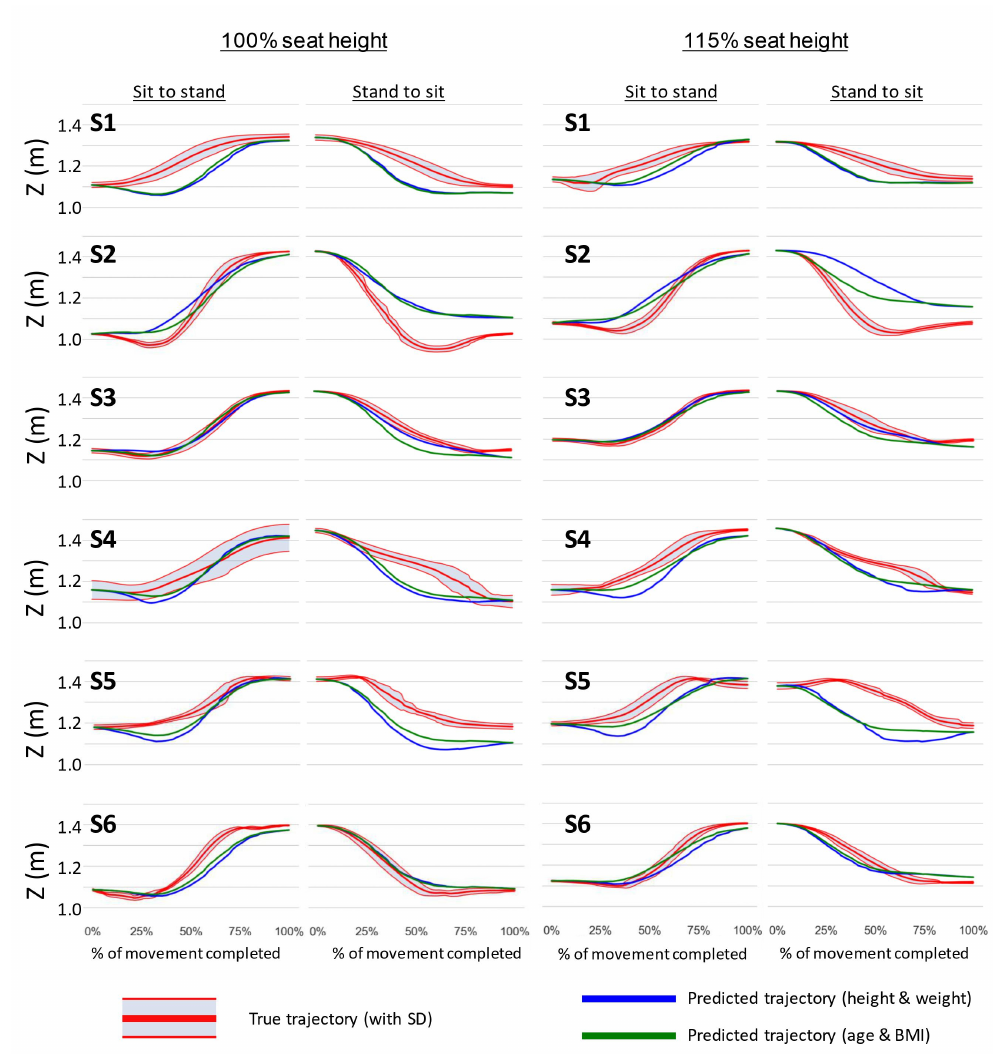
Figure 8. Trajectories predicted by k − NN and linear regression model imposed over stroke partic- ipants’ (labelled S1 – S6 ) recorded trajectories. Two left columns show sit-to-stand and stand-to-sit for 100% seat height. Two right columns show sit-to-stand and stand-to-sit for 115% seat height. Red lines show participants average true trajectory with standard deviations. Blue lines are trajectories predicted by the k − NN and linear regression model using height and weight as k − NN coordinates. Green lines are for predicted trajectories using age and BMI as k − NN coordinates. The y axes on each graph represent the Z position of the mid-shoulder point, and the x axes show percentage completion of the STSTS